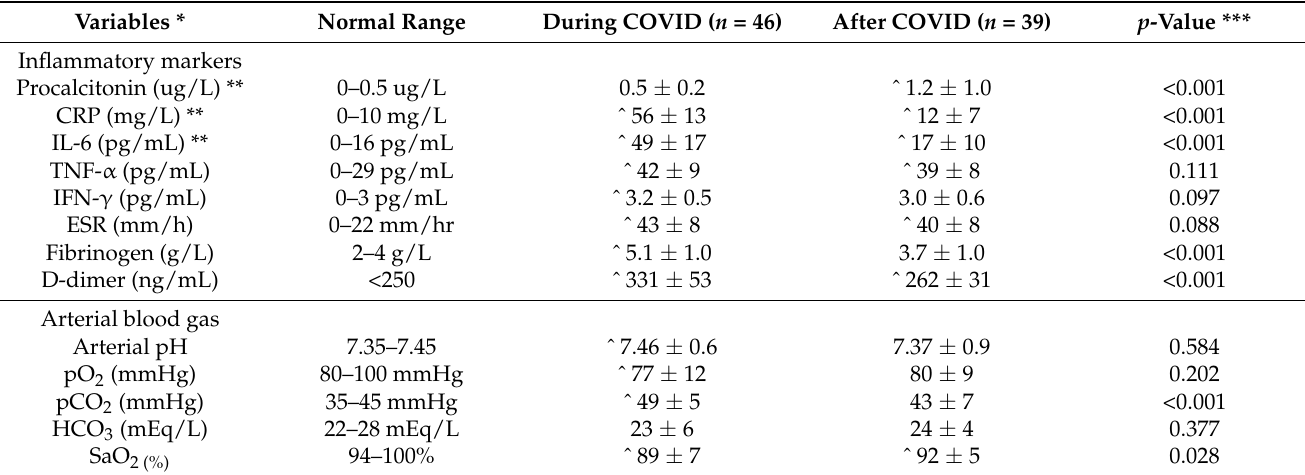
Table 3. Dynamics in inflammatory markers and blood gases of patients with cirrhosis at 4 weeks after SARS-CoV-2 infection.